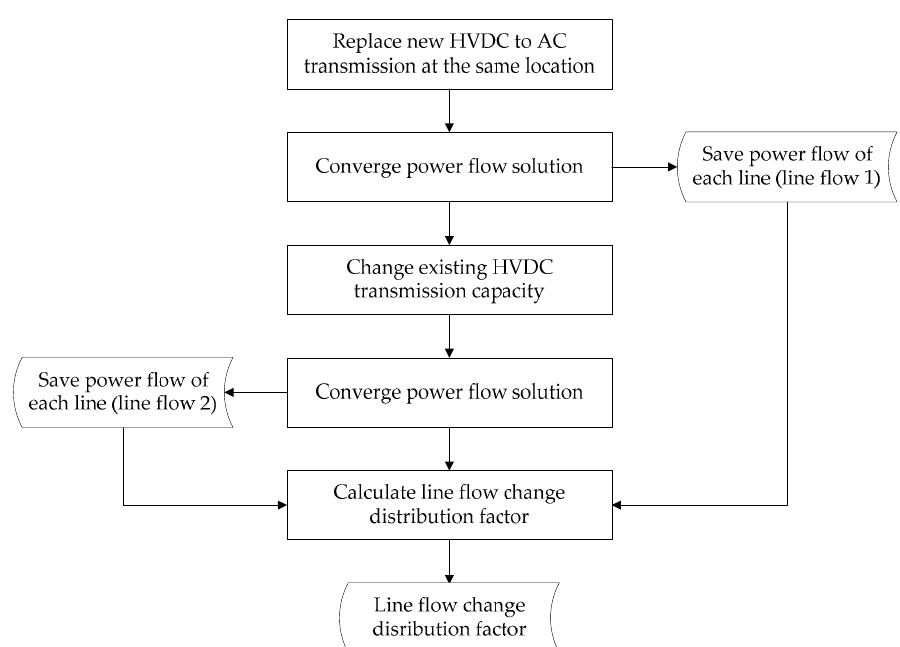
Figure 3. Calculation flowchart for line-flow change distribution factor.